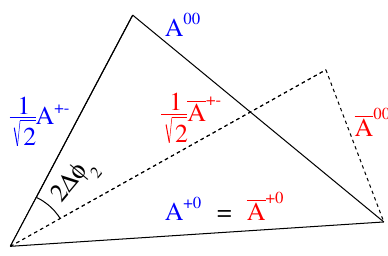
Figure 2 . Complex isospin triangles from which (cid:1) (cid:30) 2 can be